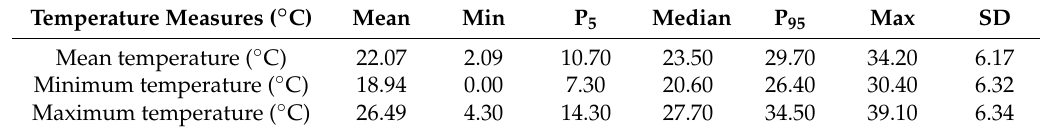
Table 1. Summary statistics of average annual temperatures in Guangzhou,